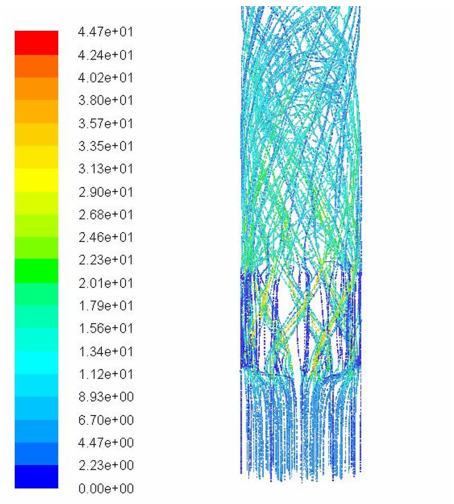
Fig. 9. Fluid trace after spiral groove bending.